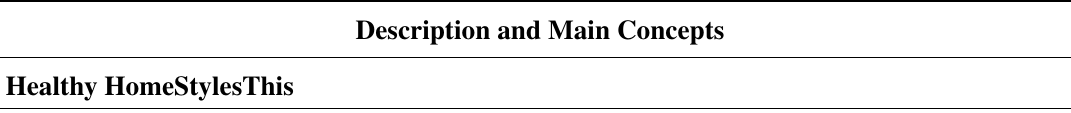
Table 1. HomeStyles guide content: Description and main